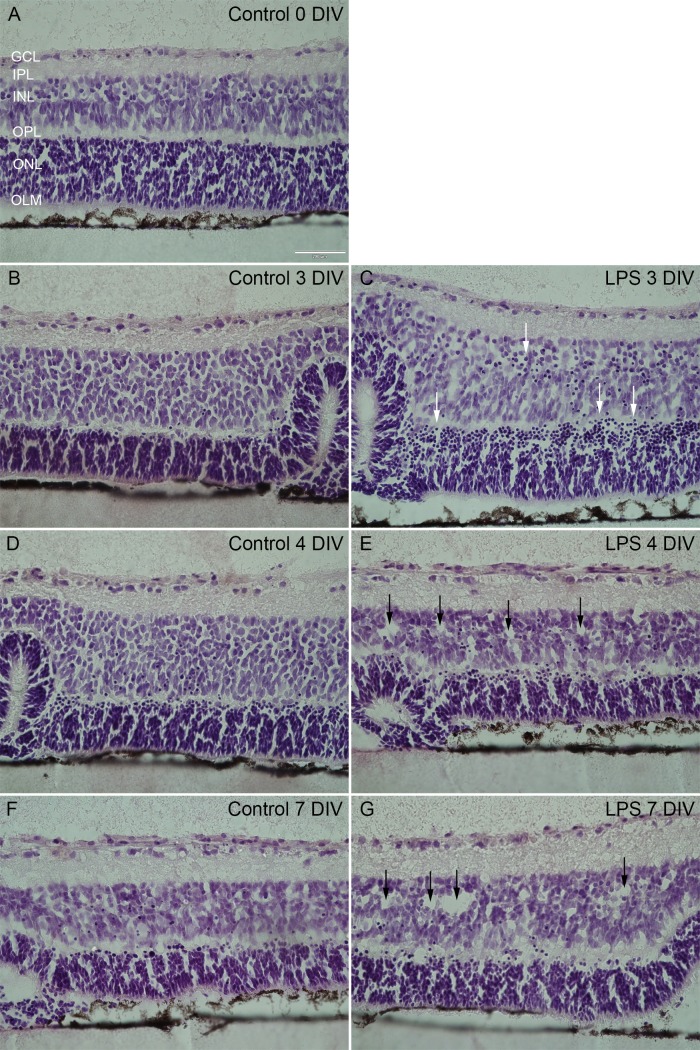
Retinal gross morphology shown by Htx-eosin staining.At the time of explantation, i.e. 0 DIV, normal retinal lamination, including three distinct nuclear layers and two synaptic layers with no folds, no rosettes and absence of pyknotic cells were found (A). Cultivation per se did not induce any architectural changes until at 7 DIV (cf. A, B, D with F). LPS exposed retinas displayed gross morphological changes at all time-points, with signs of cytotoxicity, i.e. pyknotic nuclei mainly in the INL and (see arrows in C) disseminated tissue especially in the INL (see arrows in E and G). GCL = ganglion cell layer, IPL = inner plexiform layer, INL = inner nuclear layer, OPL = outer plexiform layer, ONL = outer nuclear layer, OLM = outer limiting membrane. Scale bar: 200 μm.